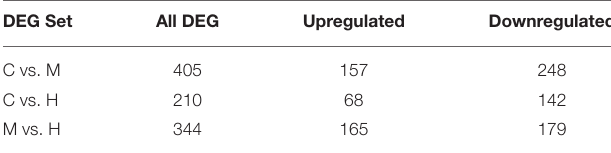
TABLE 2 | Statistics of new annotation gene number. TABLE 3 | Statistics of the number of